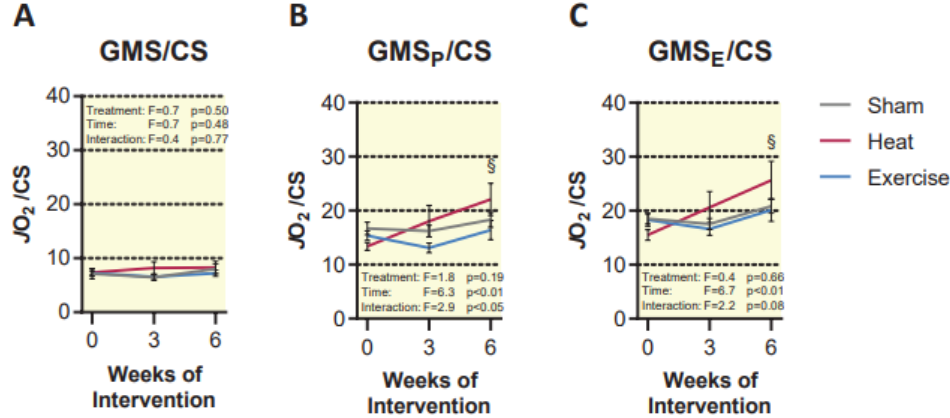
Figure 6. ( A – C ) Mitochondrial respiration normalized to citrate synthase activity. Units for this measure are nmol O 2 *s − 1 /U CS. Statistical difference in the HT group compared to baseline is indicated by § ( p < 0.01). Results are represented as mean ± SEM ( n = 8–10).